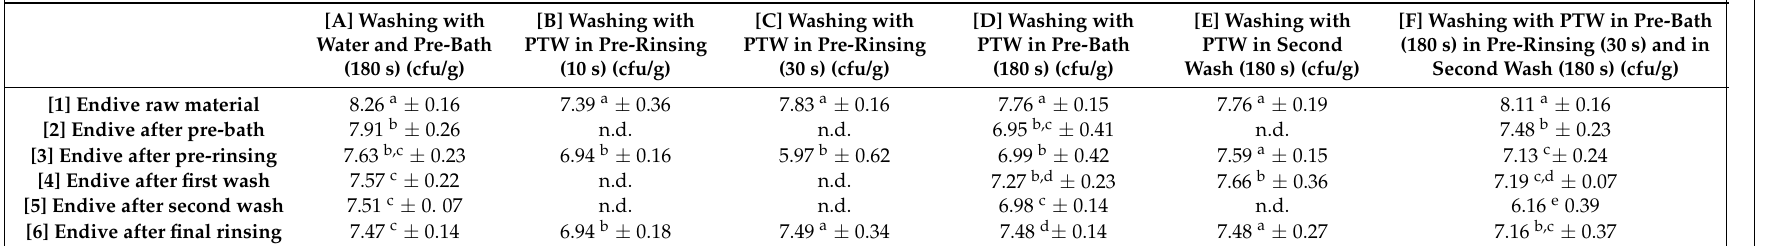
n.d.: not determined; cfu: colony-forming units. Columns with different letters indicate statistically significant differences ( p <